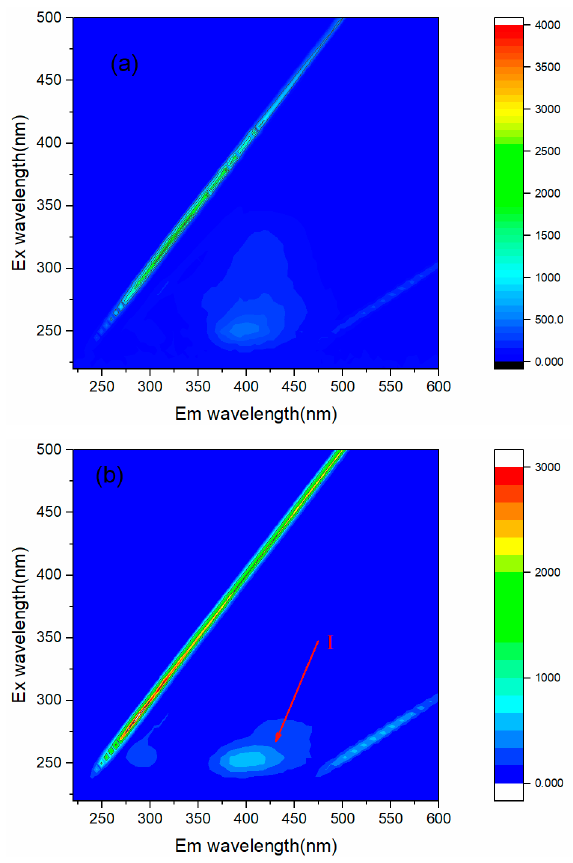
Figure 8. The 3DEEM spectrum for effluent from IR catalytic ozonation on ( a ) day 15 and ( b ) day 487.